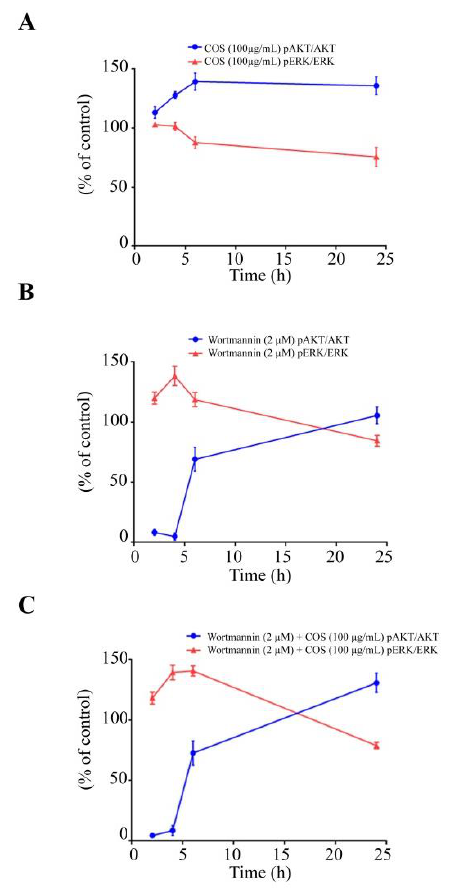
Figure 5. Time course of signaling pathways induced by COS investigated using wortmannin. ( A ) Effect of COS on p-AKT/AKT ratio and p-ERK/ERK ratio. ( B ) Effect of wortmannin on p-AKT/AKT ratio and p-ERK/ERK ratio. ( C ) Effect of COS with wortmannin pre-treatment on p-AKT/AKT ratio and p-ERK/ERK ratio. Data are expressed as % of control (vehicle-treated group) ± S.D. ( n = 3).